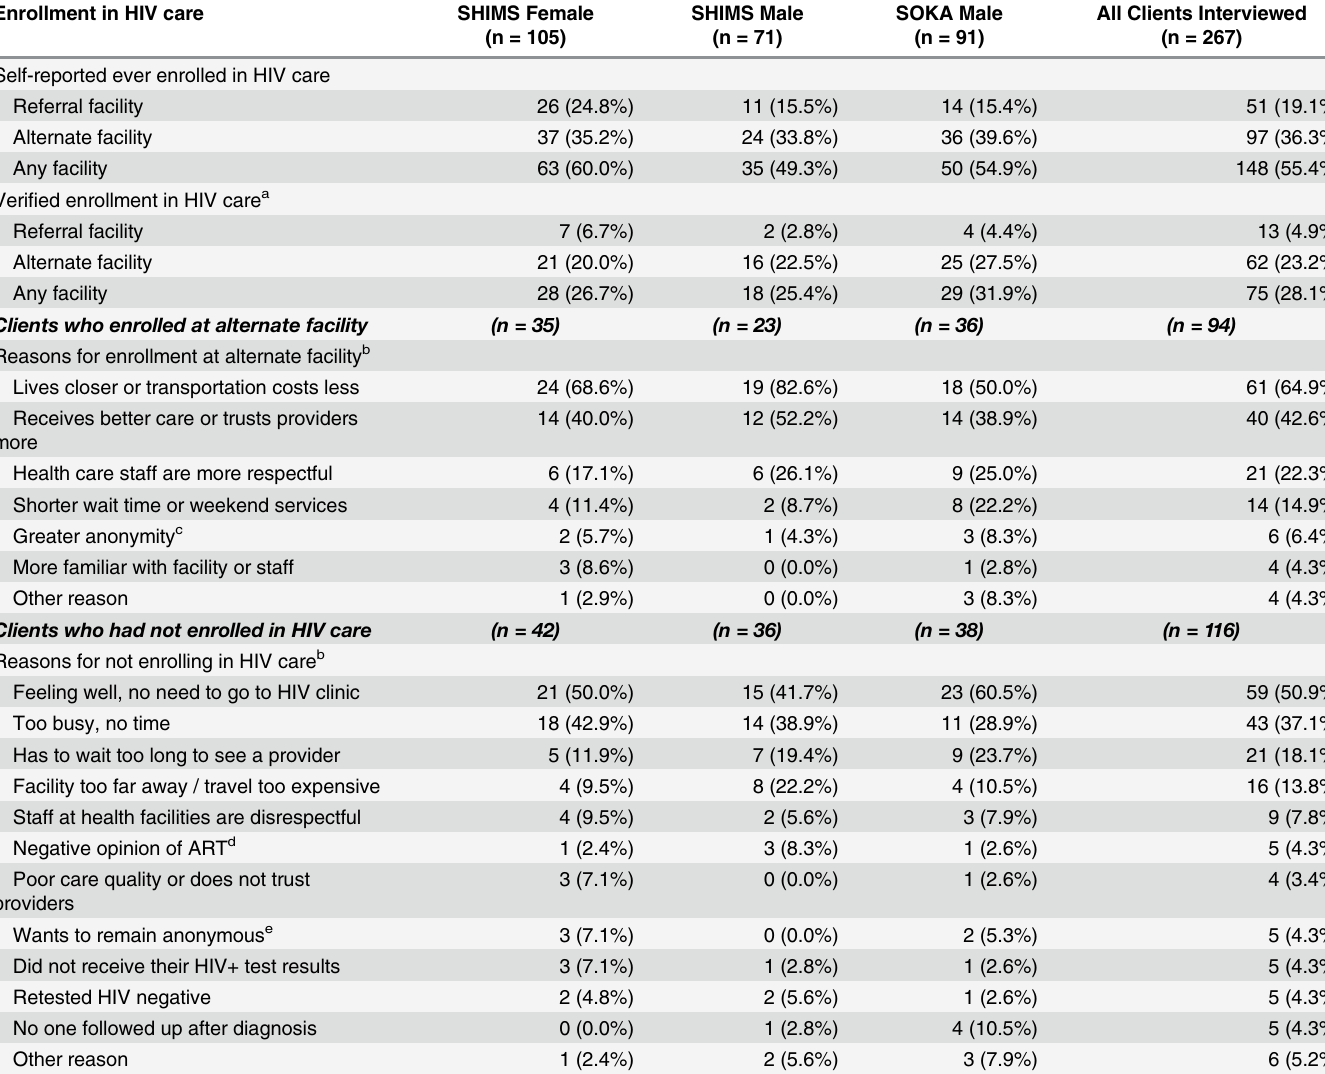
Table 2. Interviewed client self-reported and verified enrollment in HIV care, and reasons for enrolling at an alternate facility or not enrolling in HIV care at all, by study-gender group. Enrollment in HIV